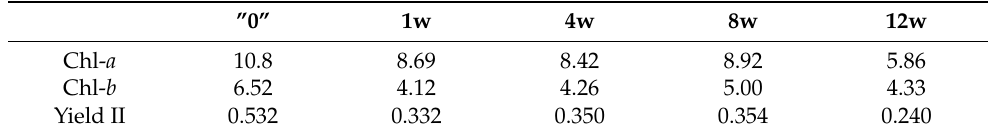
Table 3. Average chlorophyll a and b content [mg/L] and actual photochemical efficiency (yield) [-] in mosses, depending on the time of their